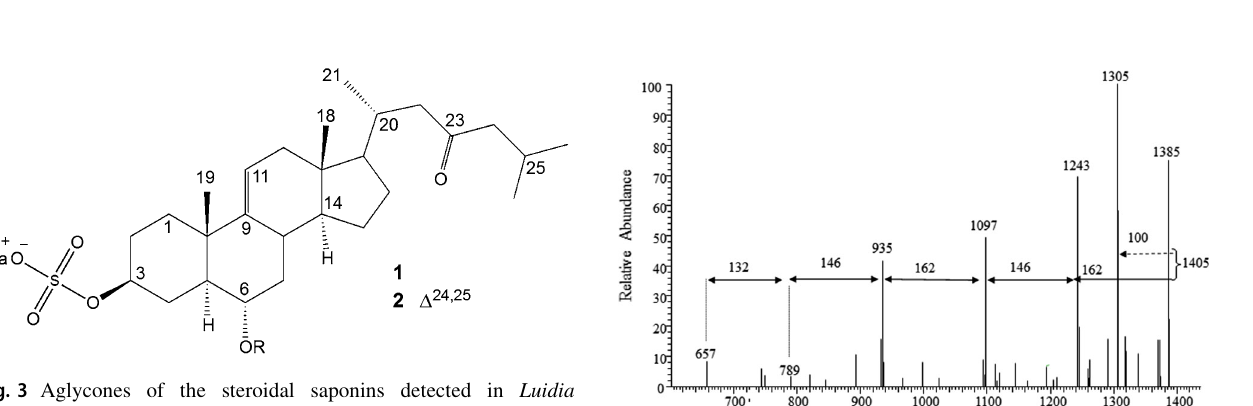
Fig. 3 Aglycones of the steroidal saponins detected in Luidia senegalensis . R corresponds to the sugar sequence described in